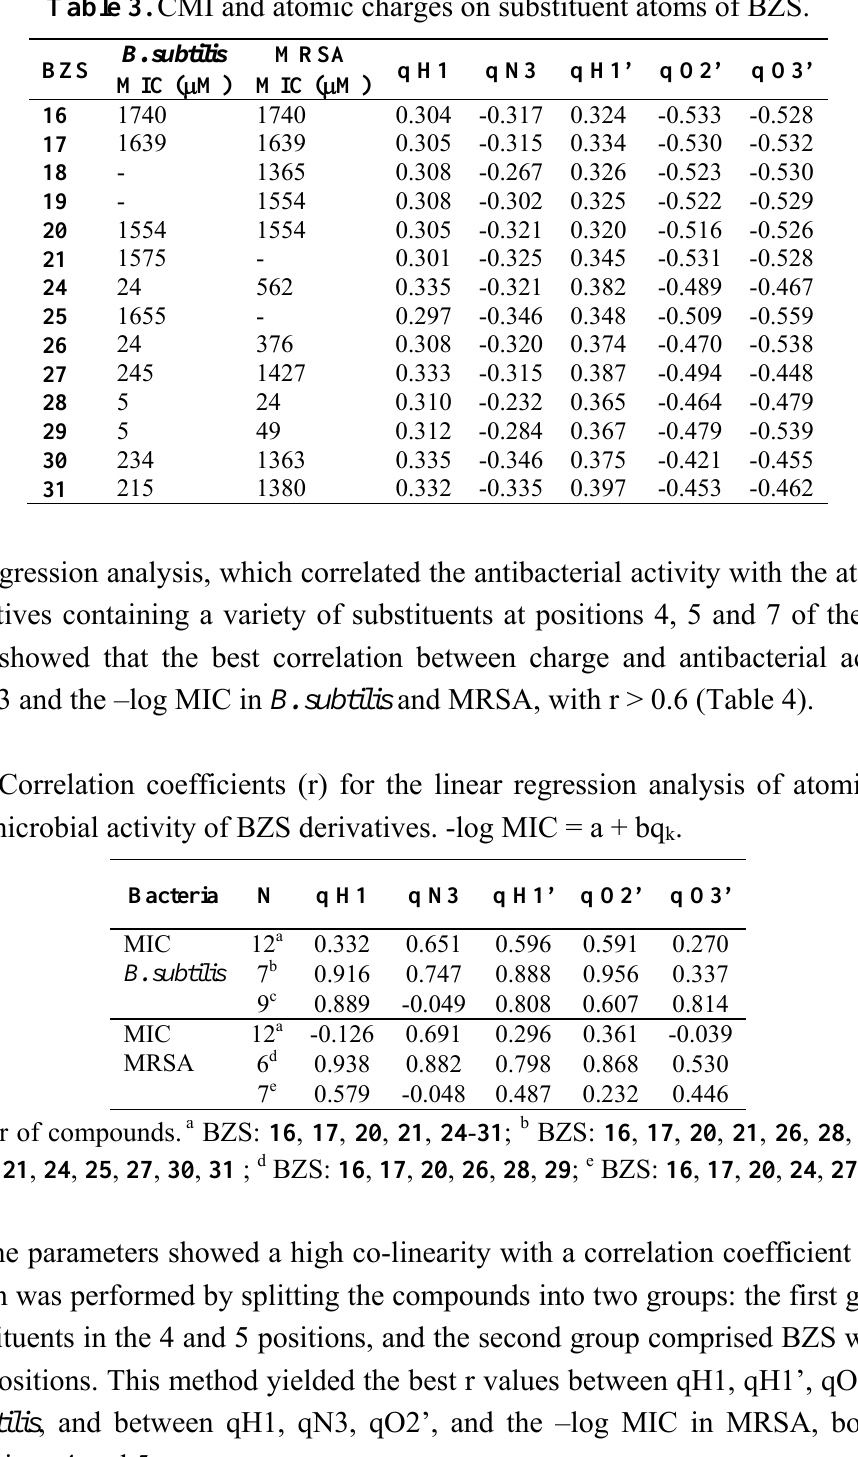
Table 3. CMI and atomic charges on substituent atoms of BZS.